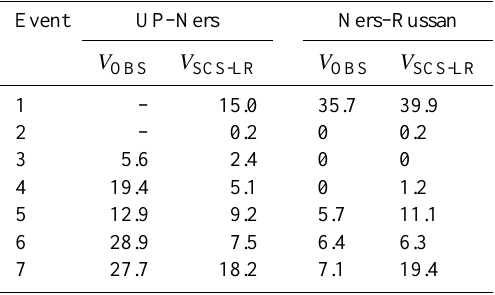
Table 5. Comparison of the differences in volumes (Mm 3 ) observed between stations ( V OBS ), and lateral inflow volumes estimated with SCS–LR ( V SCS-LR ), in both sections: Anduze/Alès (UP)–Ners and Ners–Russan. The V OBS index could not be calculated at Ners for event nos. 1 and 2, because of the lack of a rating curve during these